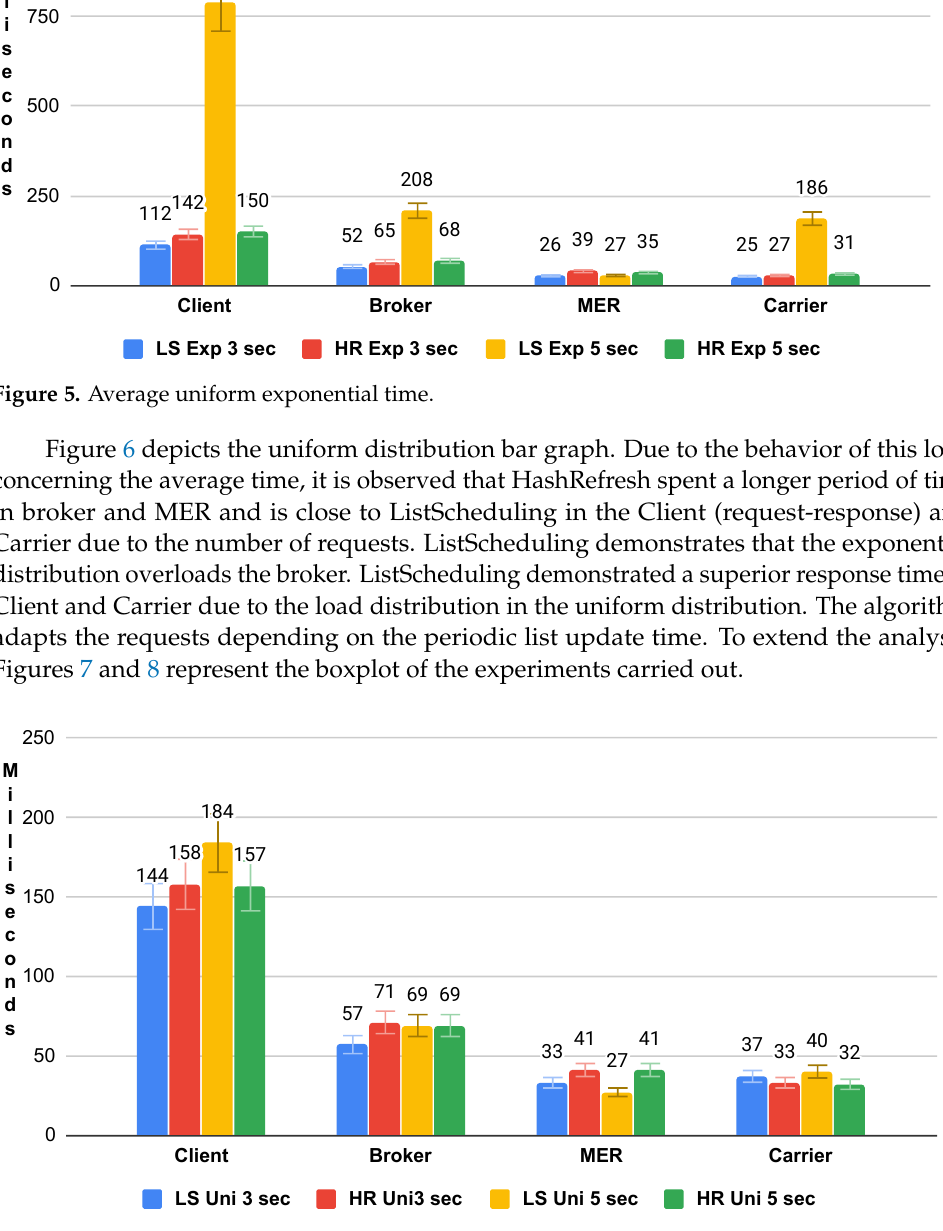
Figure 6. Average Uniform Response